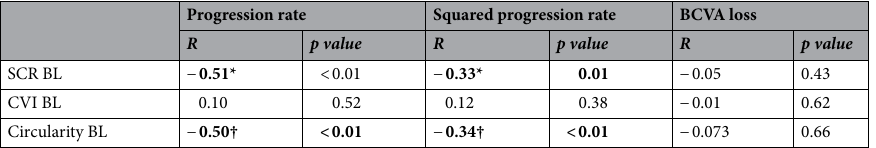
Table 3. Correlations between circularity, SCR and CVI and progression rates. Correlation coefficients between the considered variables. BCVA Best corrected visual acuity; SCR Sattler/Choroid ratio; BL Baseline; CVI Choroidal Vascularity Index. * p < .01 using Spearman’s correlation coefficient. † p < .05 using Pearson’s correlation coefficient. Significant values are in bold.